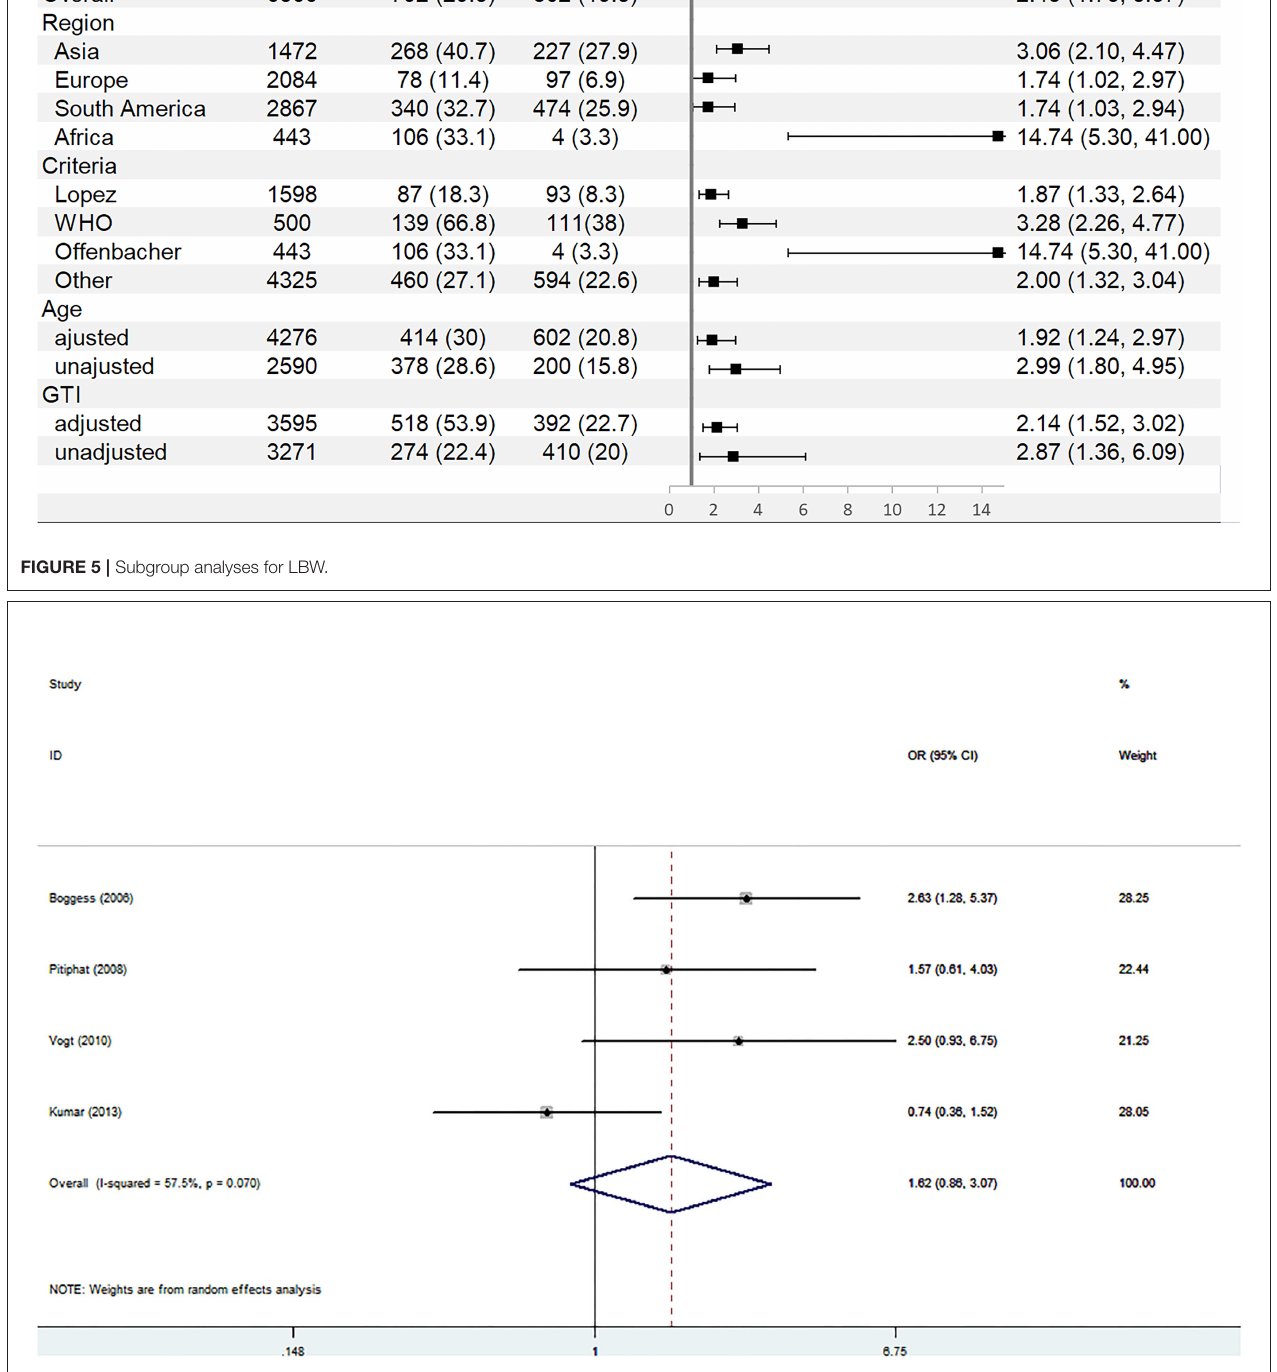
FIGURE 6 | Forest plot of small for gestational age